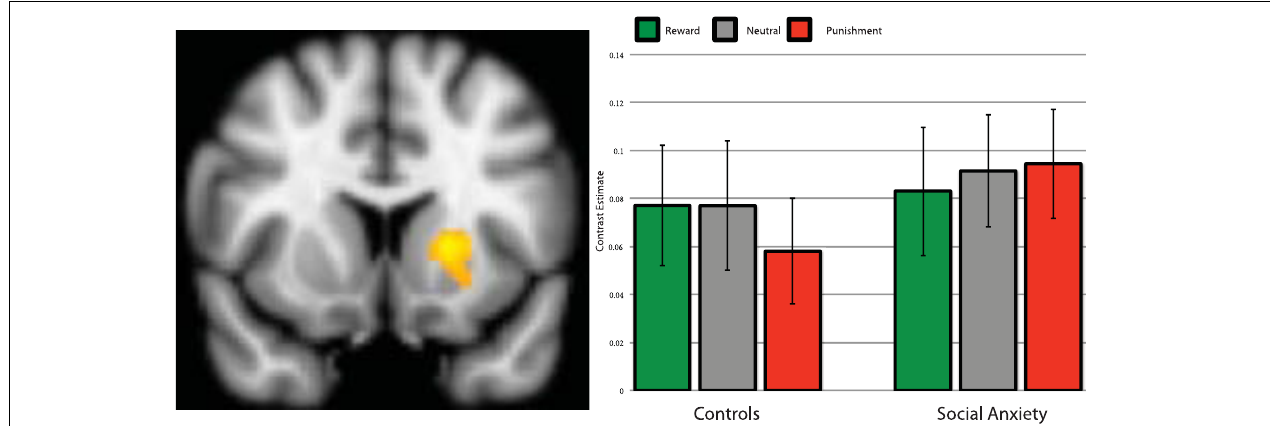
FIGURE 2 | Brain activation during anticipation in the left putamen region of interest. Parameter estimates per group and condition compared to baseline. Left side of the image is right side of the brain. Error bars are standard error of the